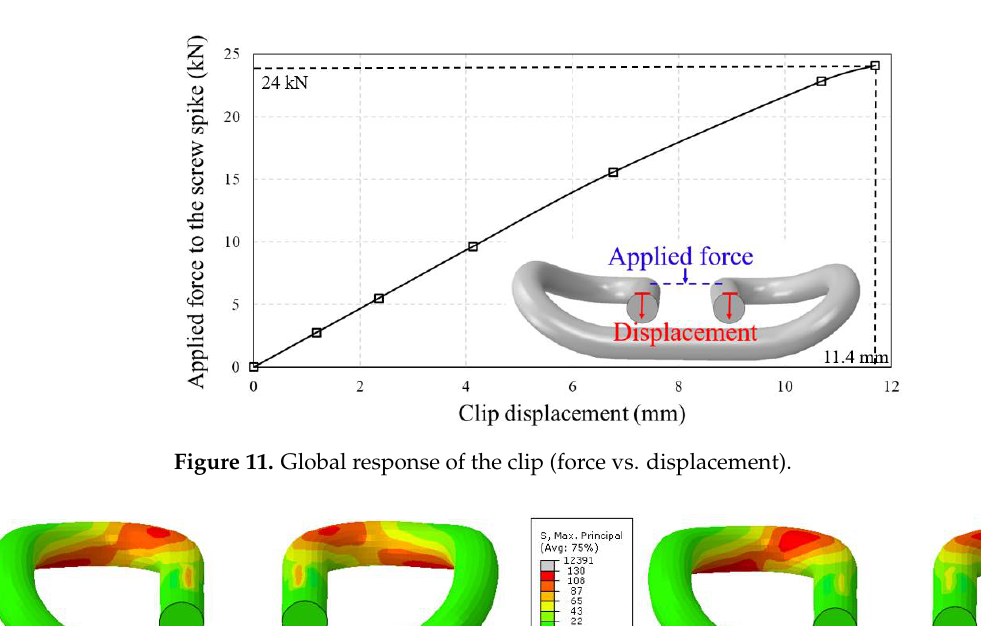
Figure 12. Principal stress contours: ( a ) step 1, ( b ) stress range between steps 1 and 2 for displacement range of 2 mm.